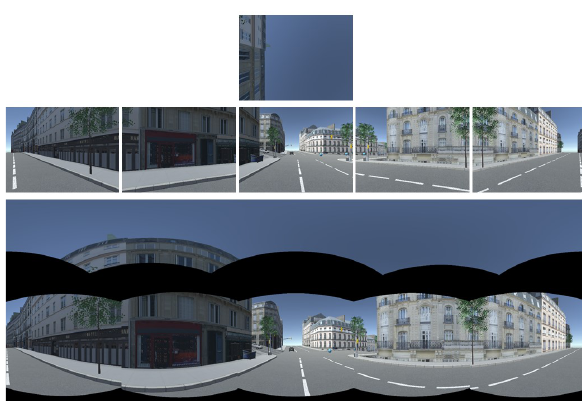
Figure 6. Individual camera images (top row, middle row) and the resulted panorama with sphere radius 20 m